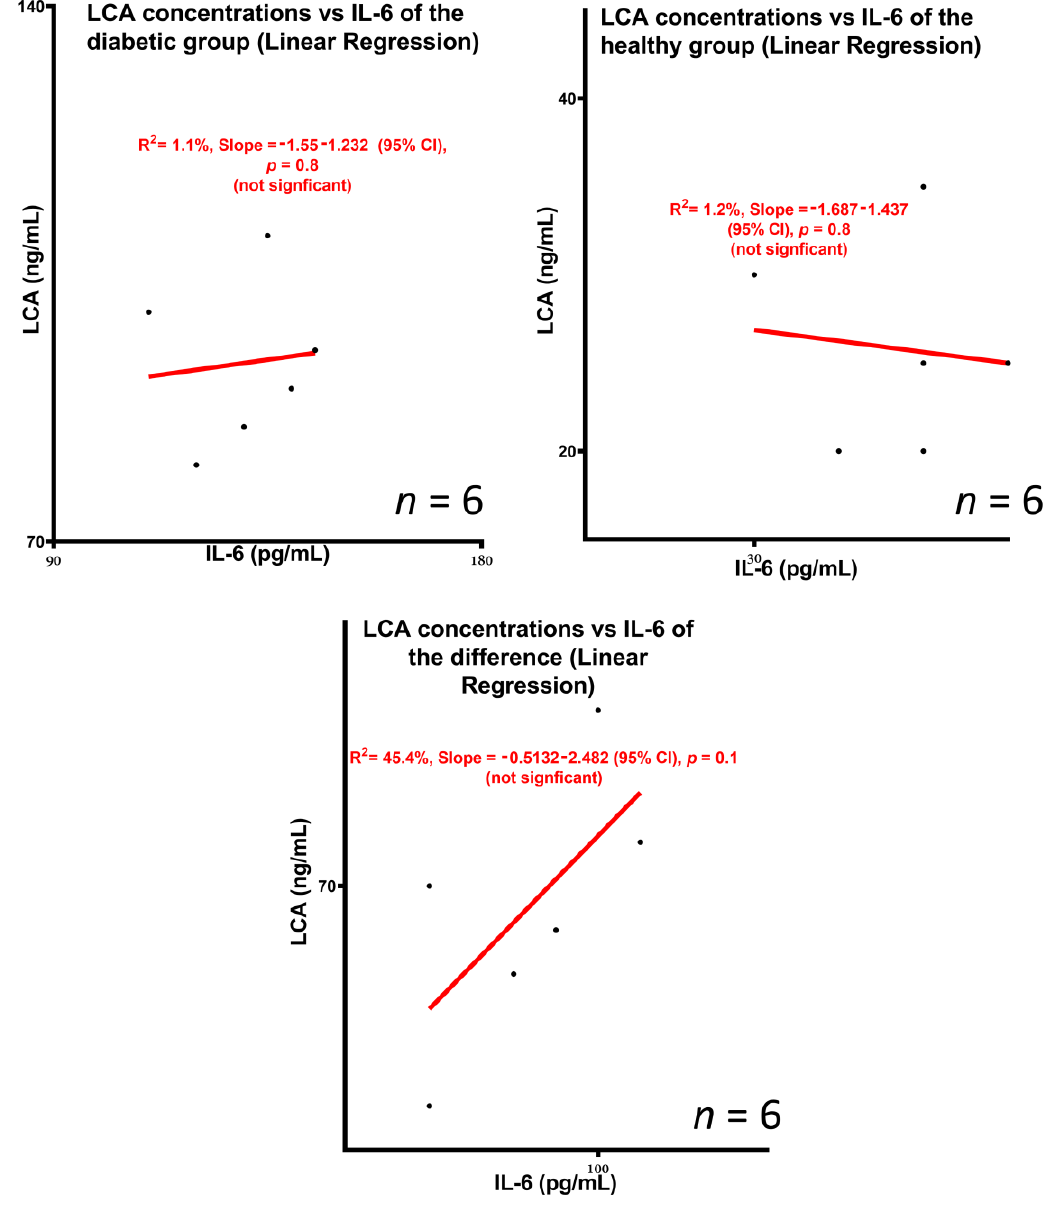
Figure 6. Linear regression between LCA concentrations and the proinflammatory cytokine IL-6.